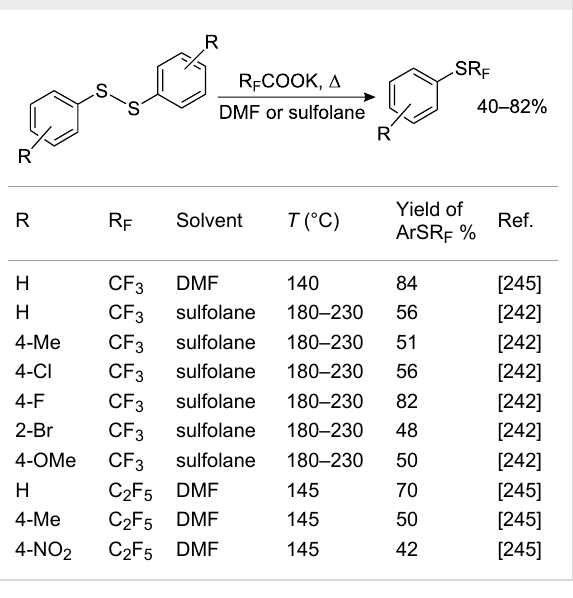
Table 14: Perfluoroalkylation of aryl disulfides by decarboxylation of perfluorocarboxylates.